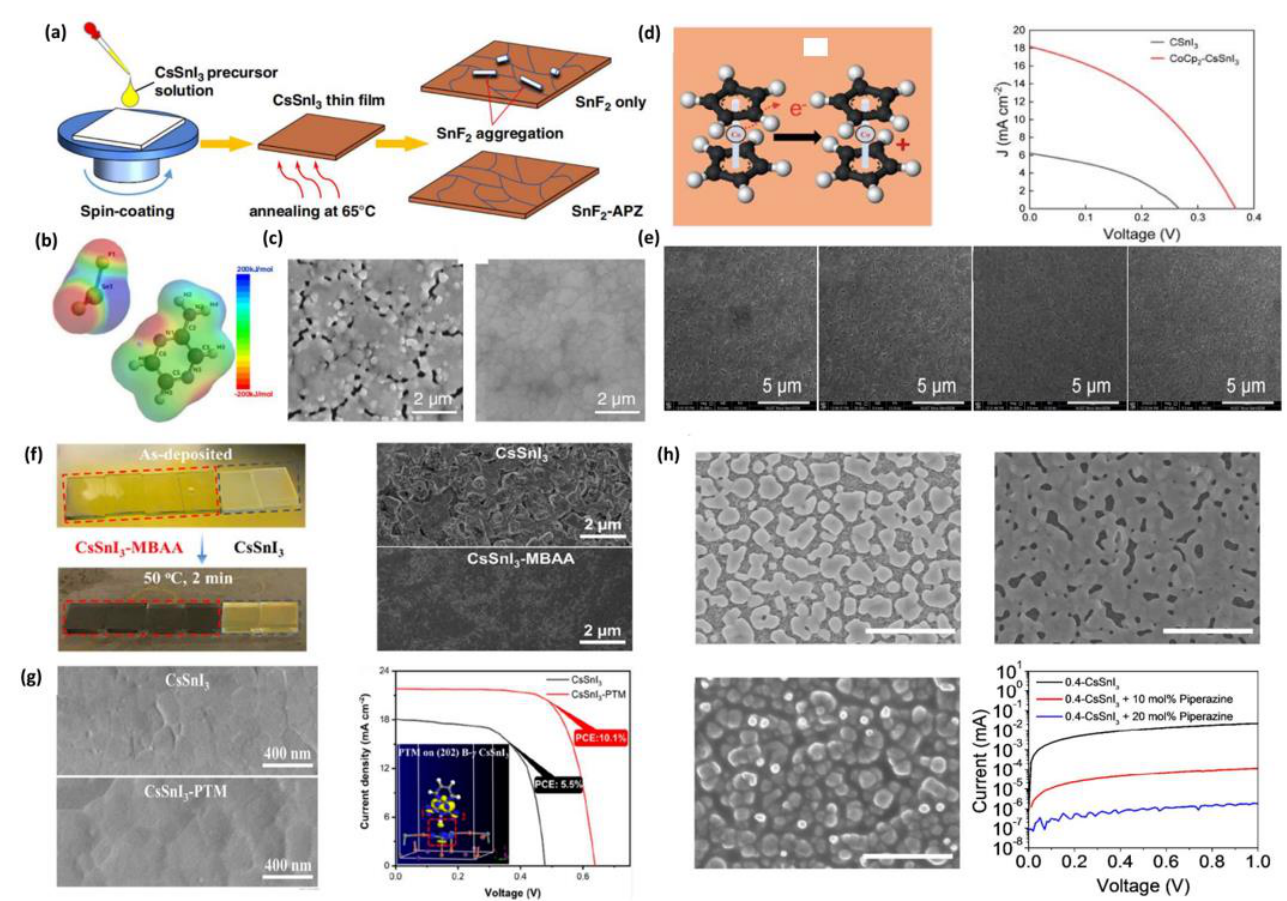
Figure 4. ( a ) Illustration for the preparation of CsSnI 3 films with SnF 2 and SnF 2 –APZ complex. ( b ) Electrostatic potential surfaces for SnF 2 and APZ. ( c ) Top–view SEM pictures of CsSnI 3 films with 0% APZ and 10 mol% APZ additives [63]. ( d ) Schematic illustration of CoCp 2 ’s redox property and J–V curves of CsSnI 3 PVSCs with and without CoCp 2 . ( e ) Top–view SEM images of CsSnI 3 films without and with different content of CoCp 2 : 0%, 0.5%, 1%, and 2% [64]. ( f ) The images show the color changes of the CsSnI 3 films with and without MBAA [29]. ( g ) Surface SEM images and performance of the CsSnI 3 and CsSnI 3 –PTM samples, respectively [66]. ( h ) SEM images and I–V characteristics of 0.4–CsSnI 3 perovskite films prepared with different concentrations of piperazine; scale bars are 2 µ m